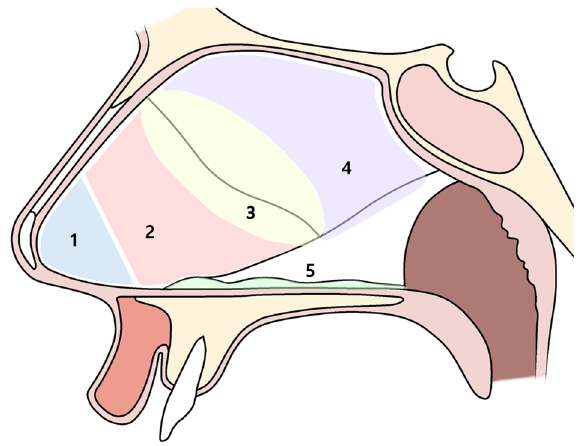
Figure 2. Classification of nasal septal deviations. Persistent septal deviations were seen in the caudal (1), anterior (2), middle (3), posterior (4) septum, and in the maxillary crest